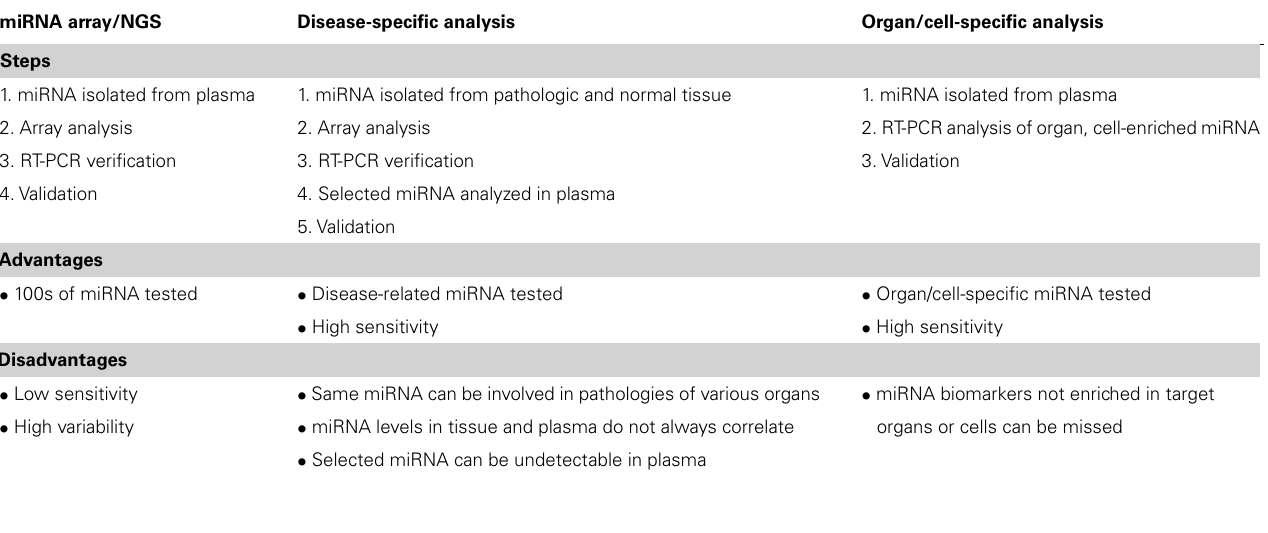
Frontiers in Cellular